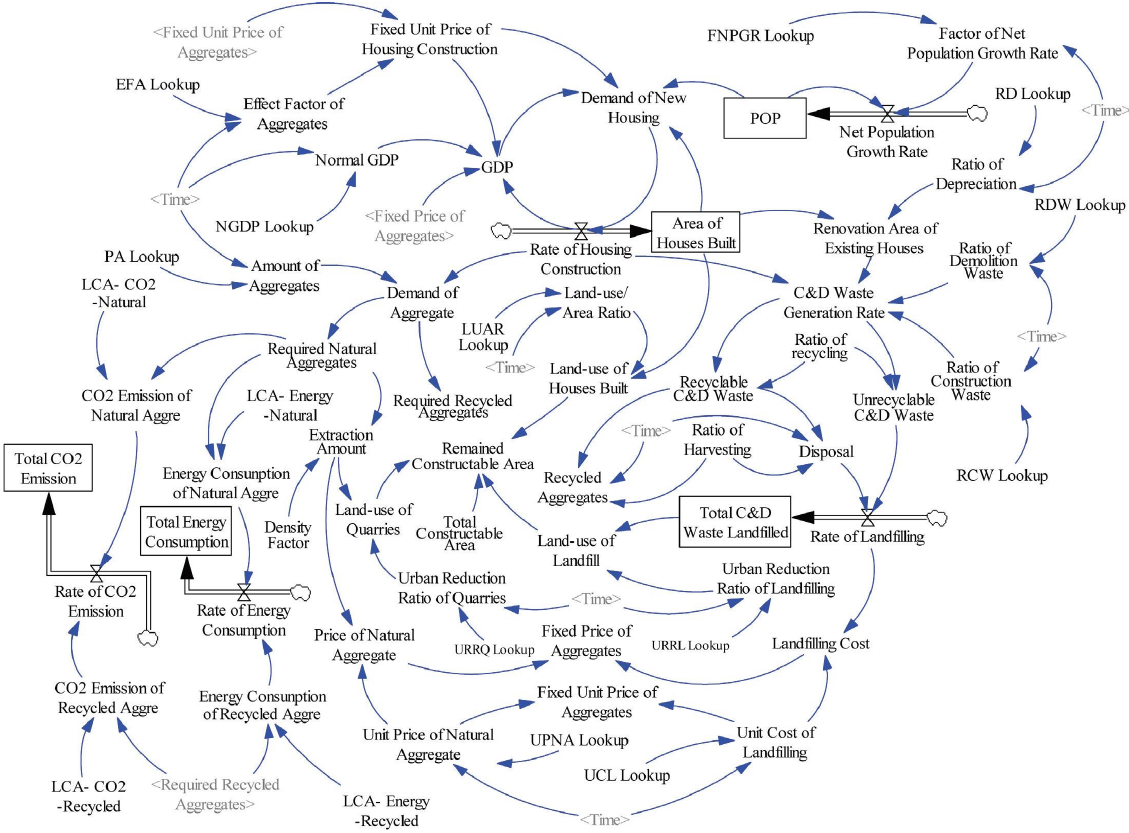
Figure 5: Chart of stock-fow of recycling policy.